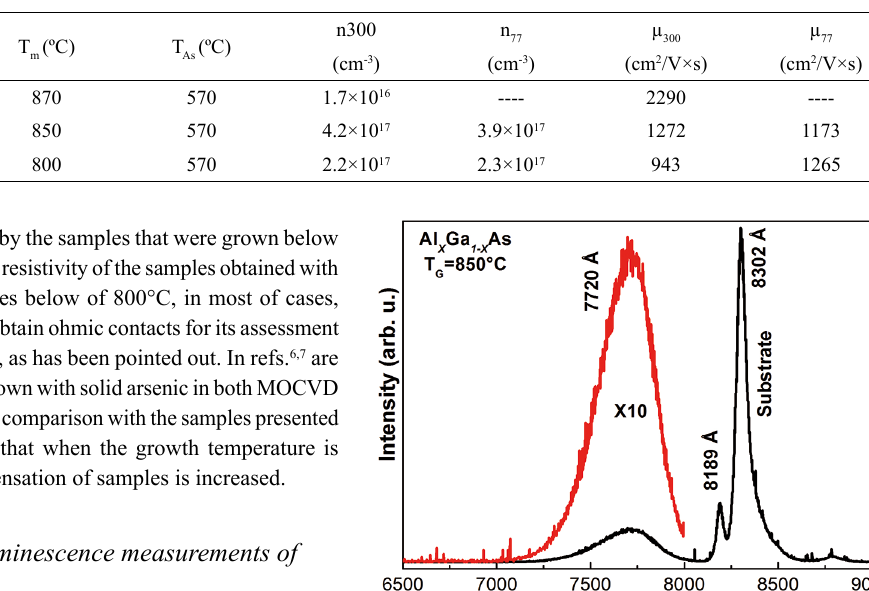
Figure 3: Typical photoluminescence spectrum for MOCVD-Al layer, which was grown using metallic arsenic as arsenic